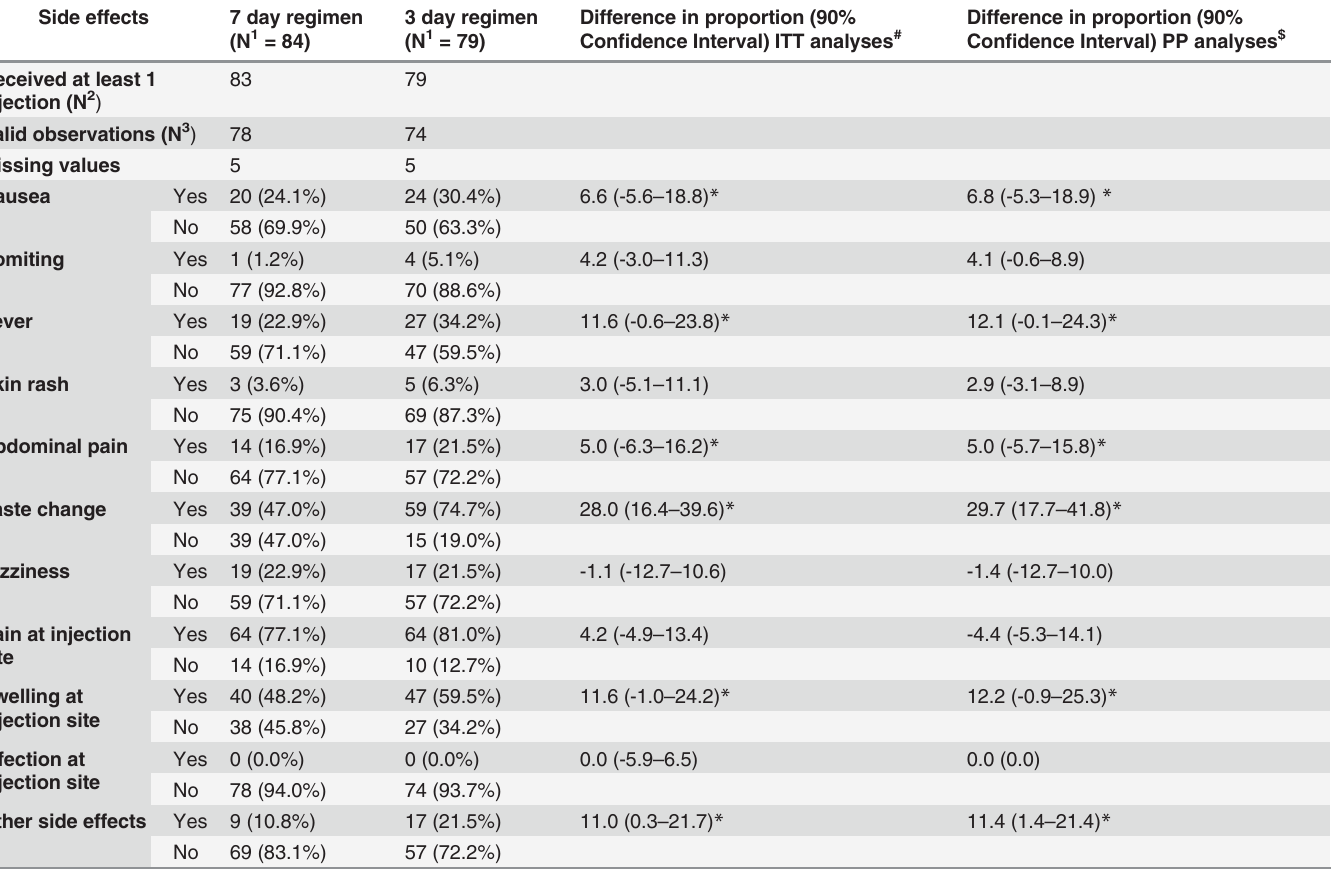
Table 4. Safety analyses: Adverse events 1 week after treatment according to treatment group of cutaneous leishmaniasis patients in Suriname from 2010 – 2013